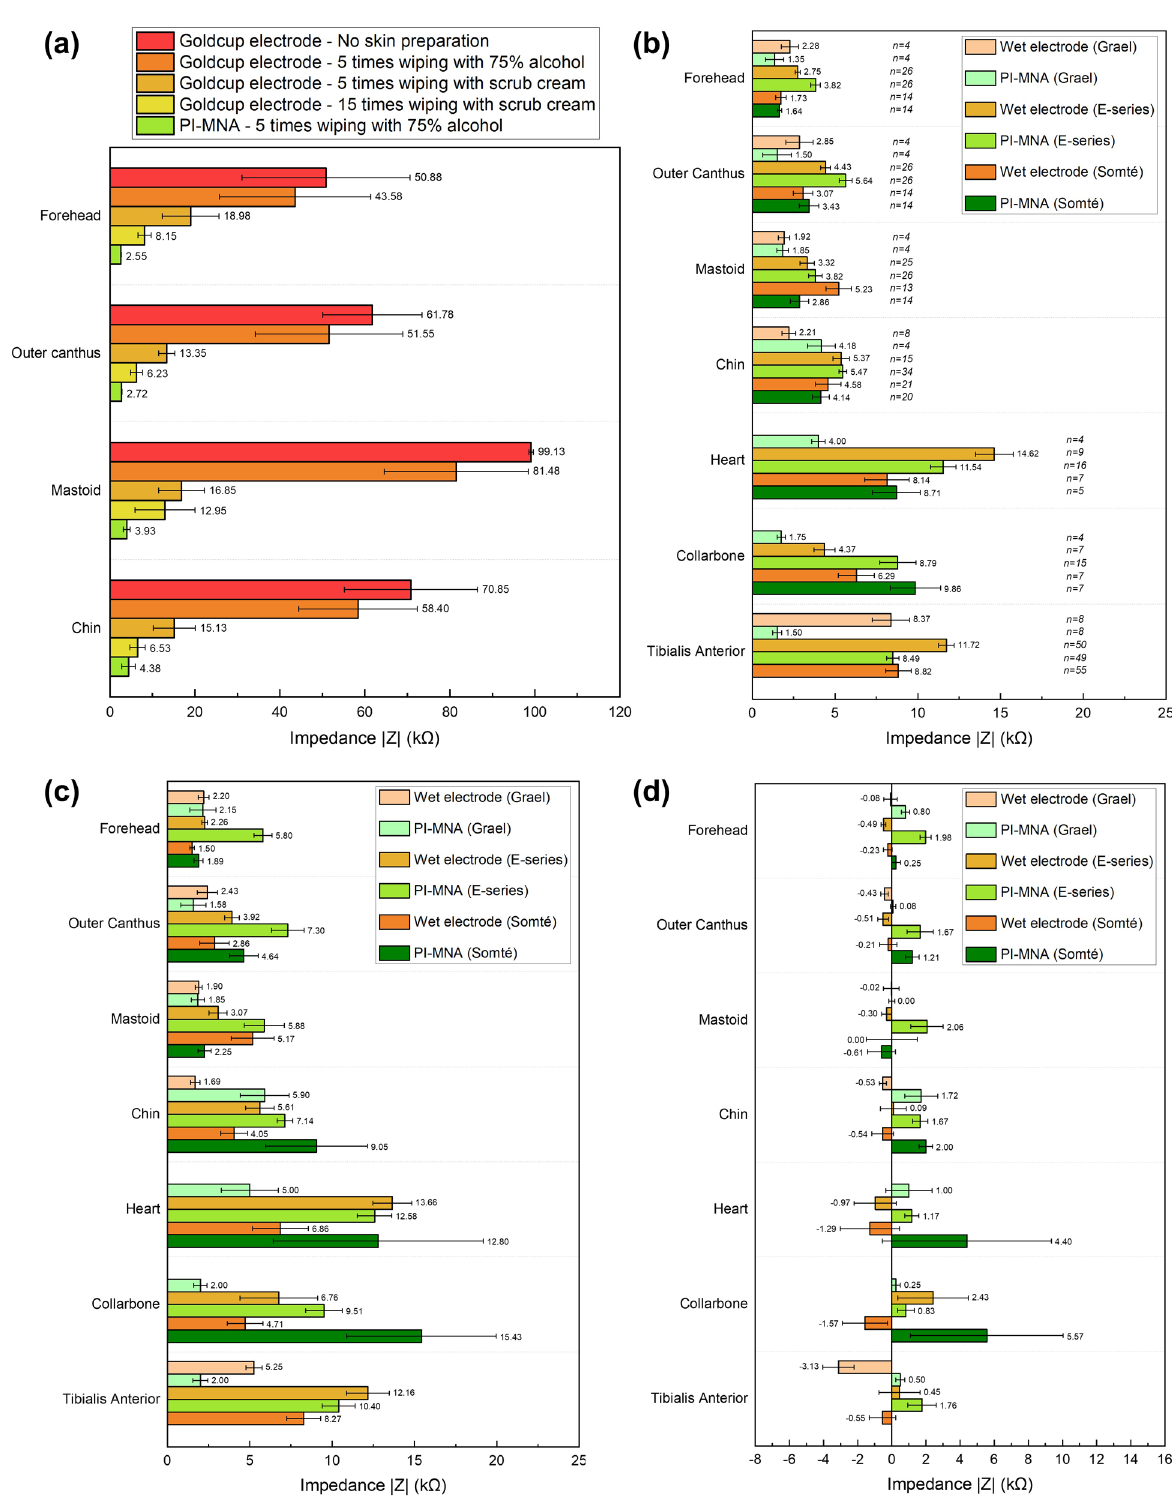
Fig. 9 a EII property (1 kHz) of wet electrodes under different skin preparation conditions compared to that of the PI-MNA electrodes without skin preparation at four key locations of PSG ( n = 4, mean ± standard error). Average EII (1 kHz) of electrodes b before and c after whole- night recording. d The changed values of EII (1 kHz) at the end of monitoring compared to those before monitoring. The number of electrodes included in the statistics of each case is provided in b (mean ± standard